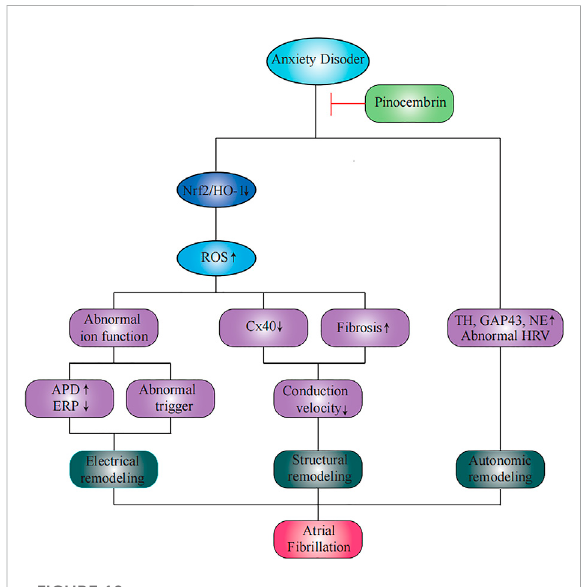
FIGURE 10 A summary of the effects of pinocembrin on atrial fi brillation susceptibility in rats with anxiety